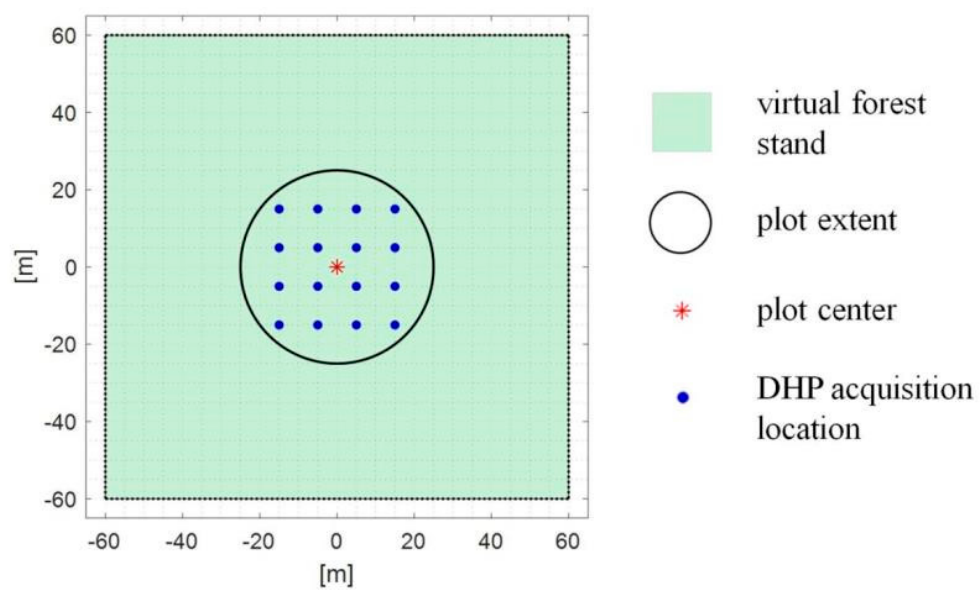
Figure 4. The plot extent and the DHP acquisition locations inside the virtual forest.